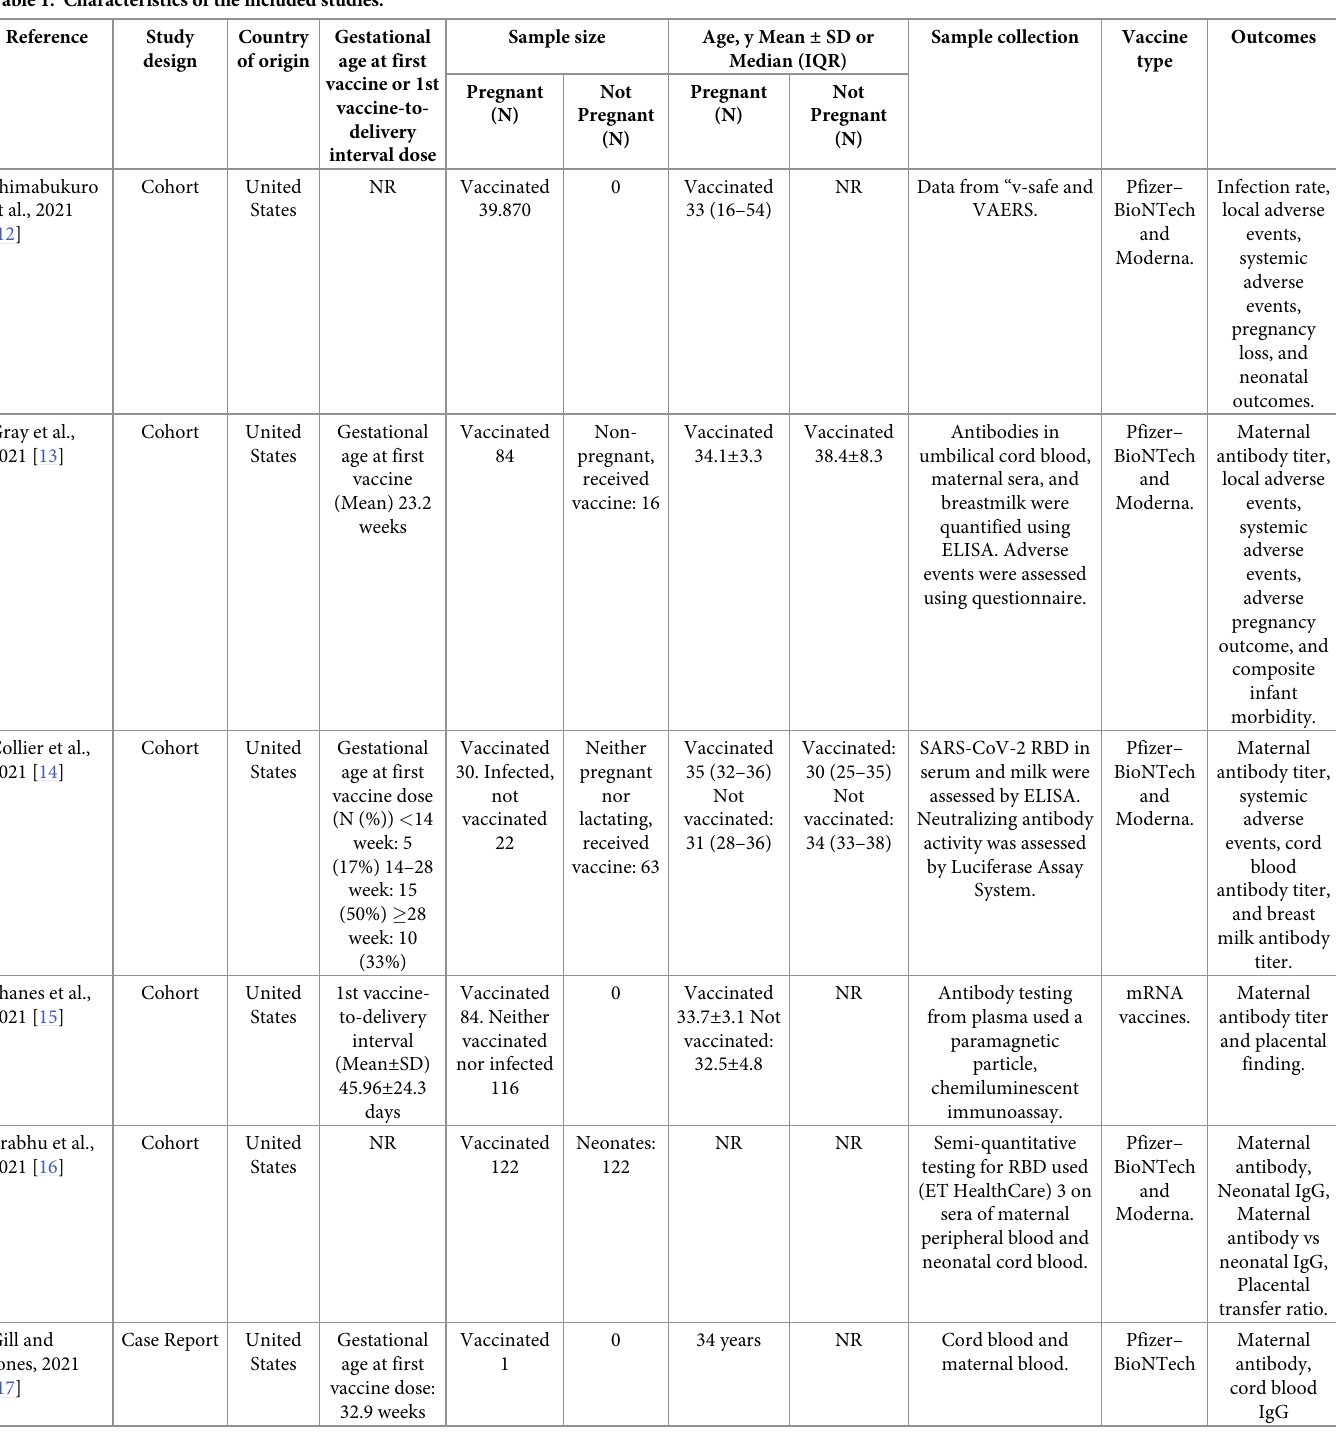
Table 1. Characteristics of the included